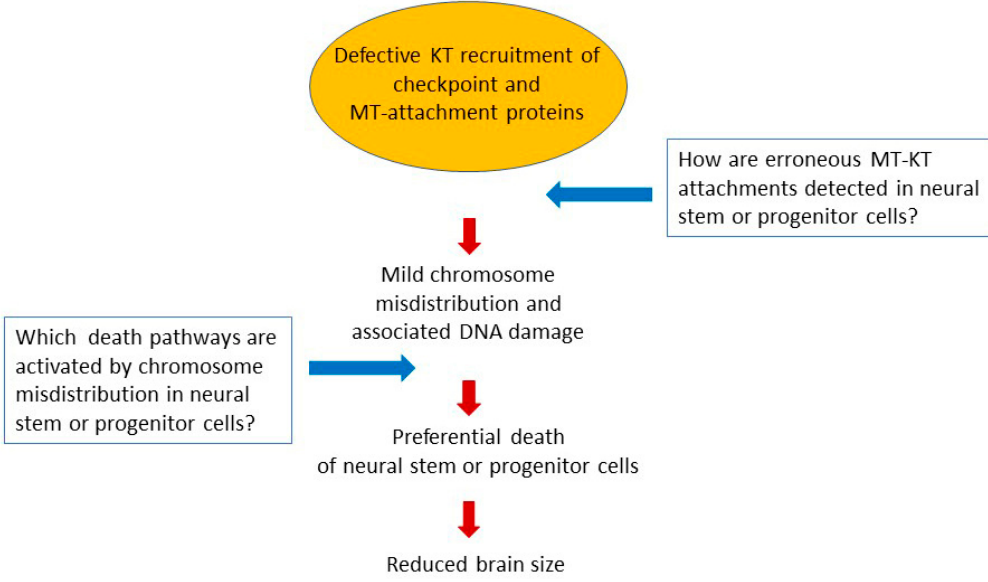
Figure 2. Hypothetical model and unresolved issues on the role of kinetochore dysfunction in microcephaly.